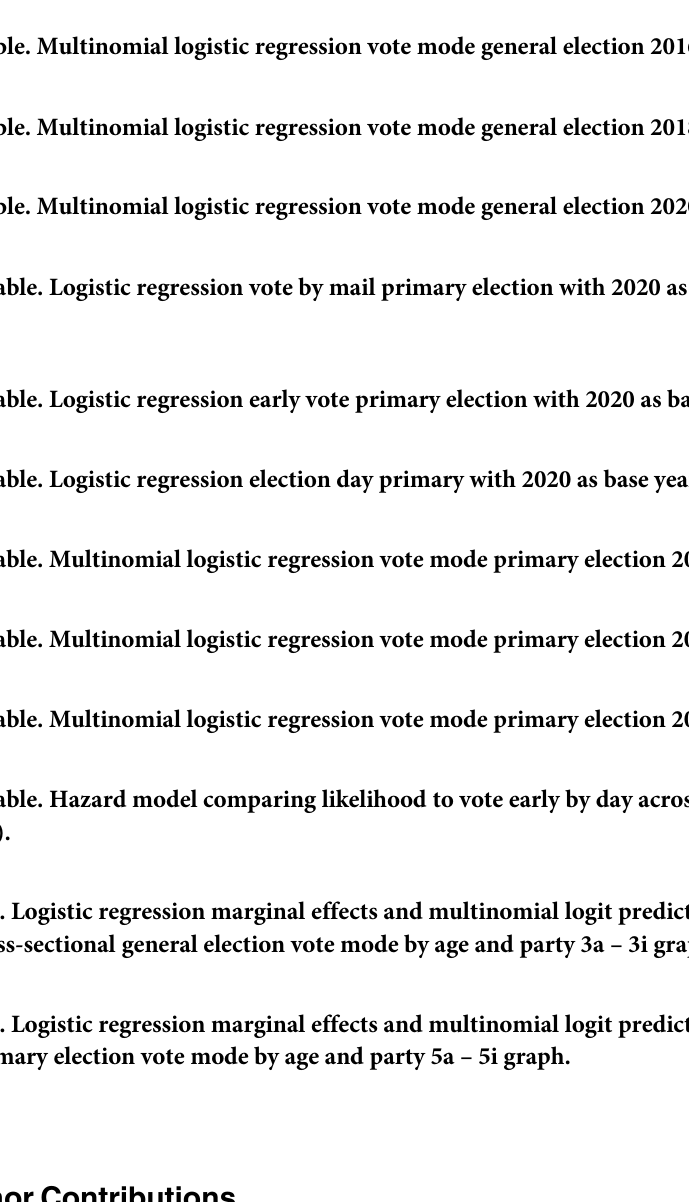
S3 Table. Hazard model descriptive statistics.